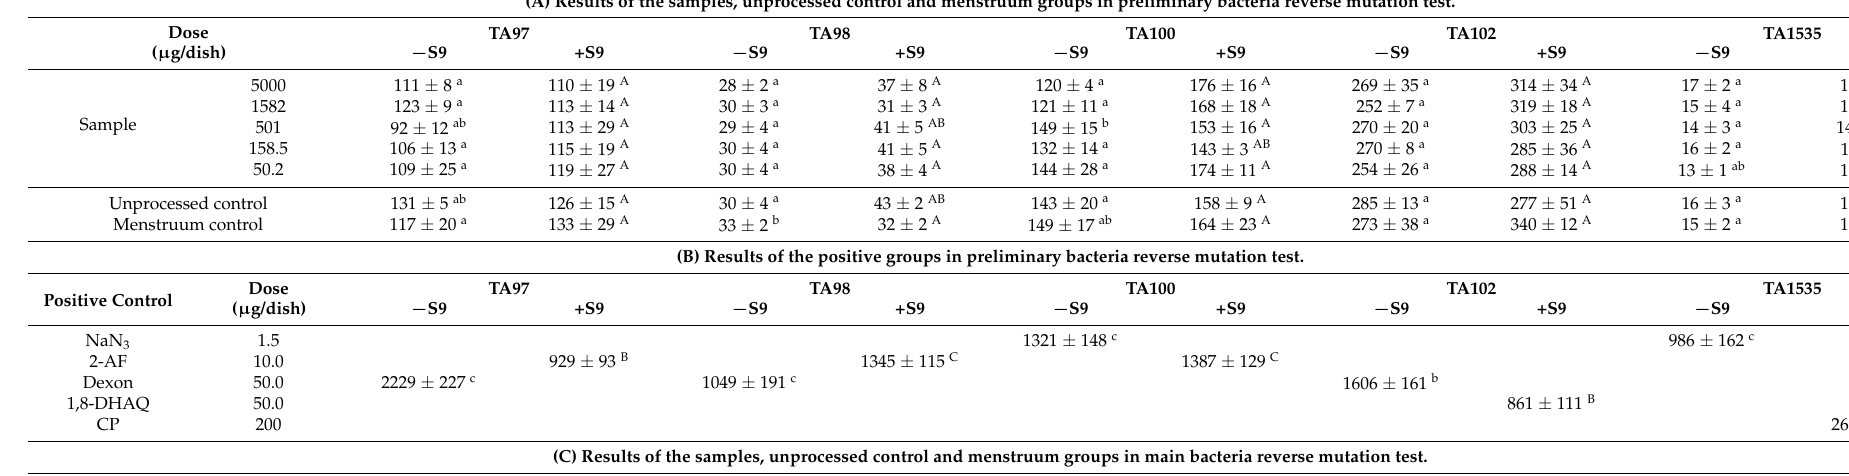
Table 6. Result of the bacteria reverse mutation test in